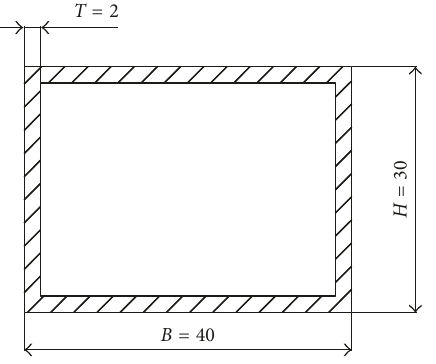
Figure 4: Sectional geometry.